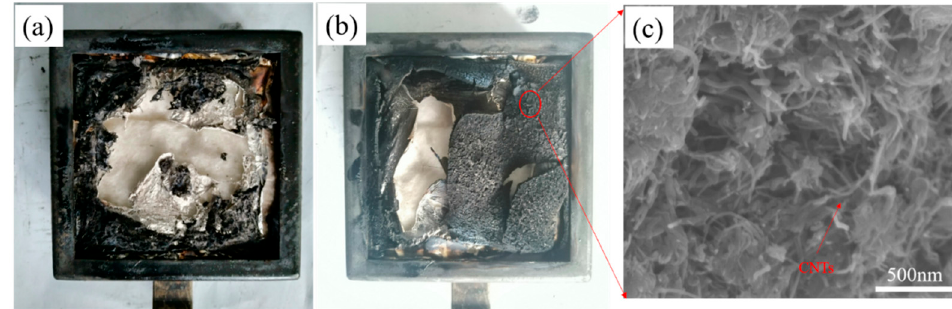
Figure 9. ( a ) Digital photos of carbon residue of EP and ( b ) composites EP/CNTs-M10; ( c ) SEM of carbon residue of composites EP/CNTs-M10.